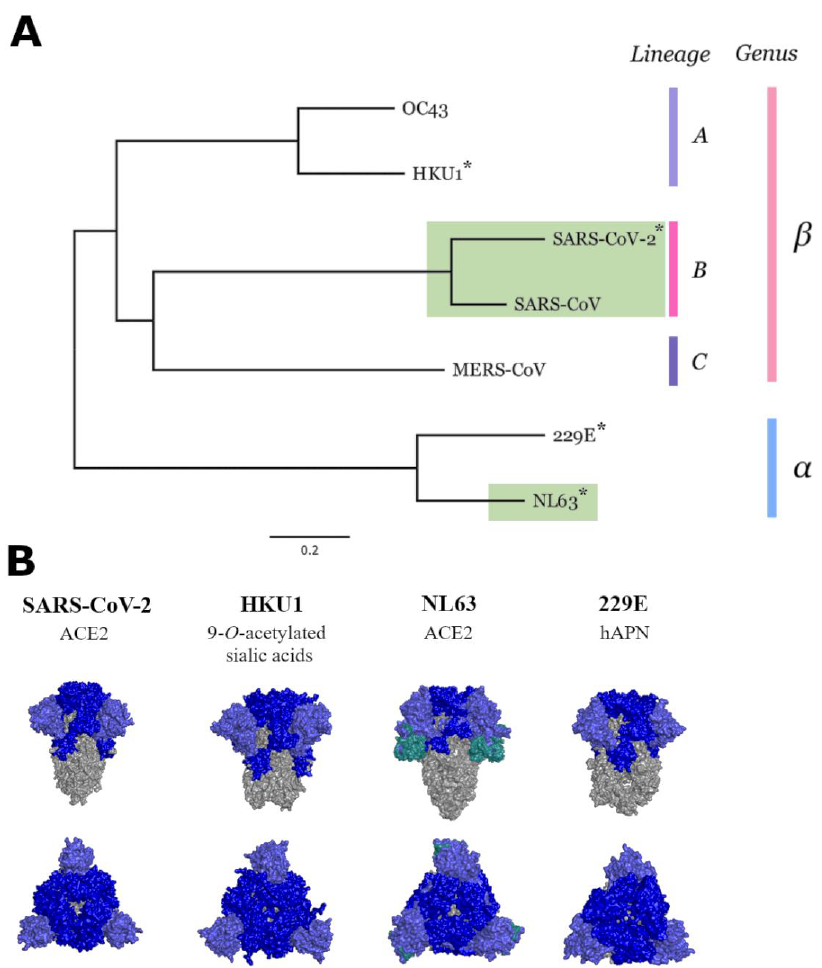
Figure 1. Phylogenetic tree of the members in the Coronaviridae family. * denotes spike proteins that were used in this study ( A ). Structures of spike proteins of SARS-CoV-2, and three of the seasonal HCoVs; HKU1, NL63 and 229E, which were used in this study ( B ). (PDB codes: 6VXX, 60HW, 6U7H, 5I08, and 5SZS). Grey denotes the S2 domain, whereas light blue is the N-terminal domain of S1 subunit, and dark blue represents the remaining S1 subunit. NL63 has an additional teal coloured section representing a unique region in the S1 domain not observed in other coronaviruses